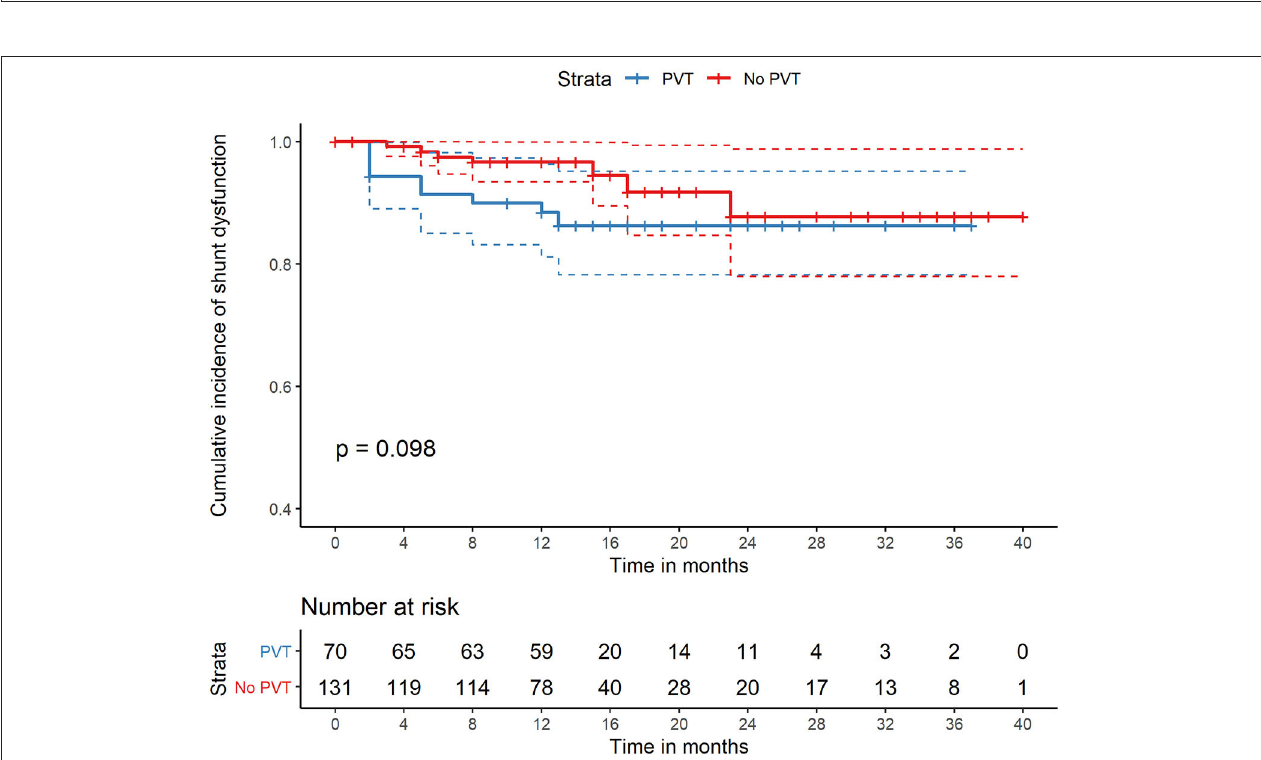
FIGURE 3 | Comparison of cumulative incidence of shunt dysfunction of patients with PVT and without PVT who were all treated with TIPS. PVT, portal vein thrombosis; TIPS, transjugular intrahepatic portosystemic shunt.